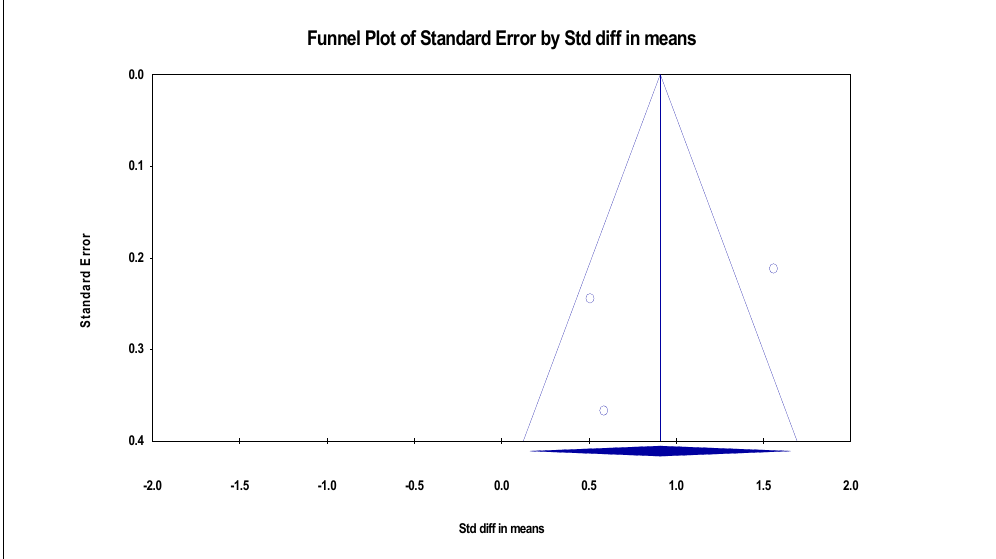
Figure 4. Funnel plot of HAMD effect of MBCT on depression.